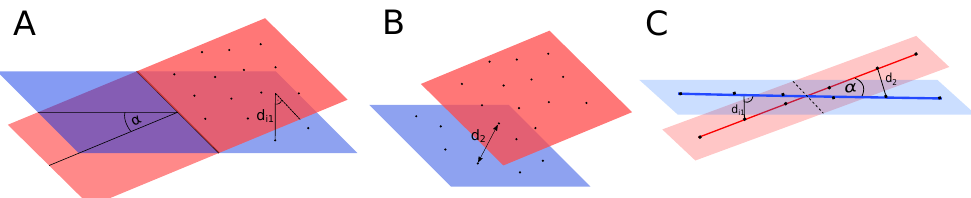
Figure 9. Angle between two planes ( α ) and exemplary point-to-plane distance ( d i 1 ) ( A ), distance d 2 between two points that belong to planes considered for merge ( B ), angle between two lines α , an exemplary point-to-line distance d i 1 and distance between two points that belong to lines considered for matching d 2 ( C ).